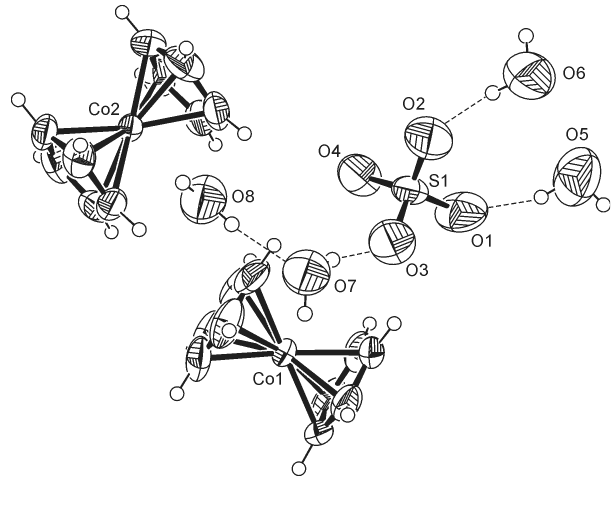
Table 2. Atomic coordinates and displacement parameters (in Å 2 )